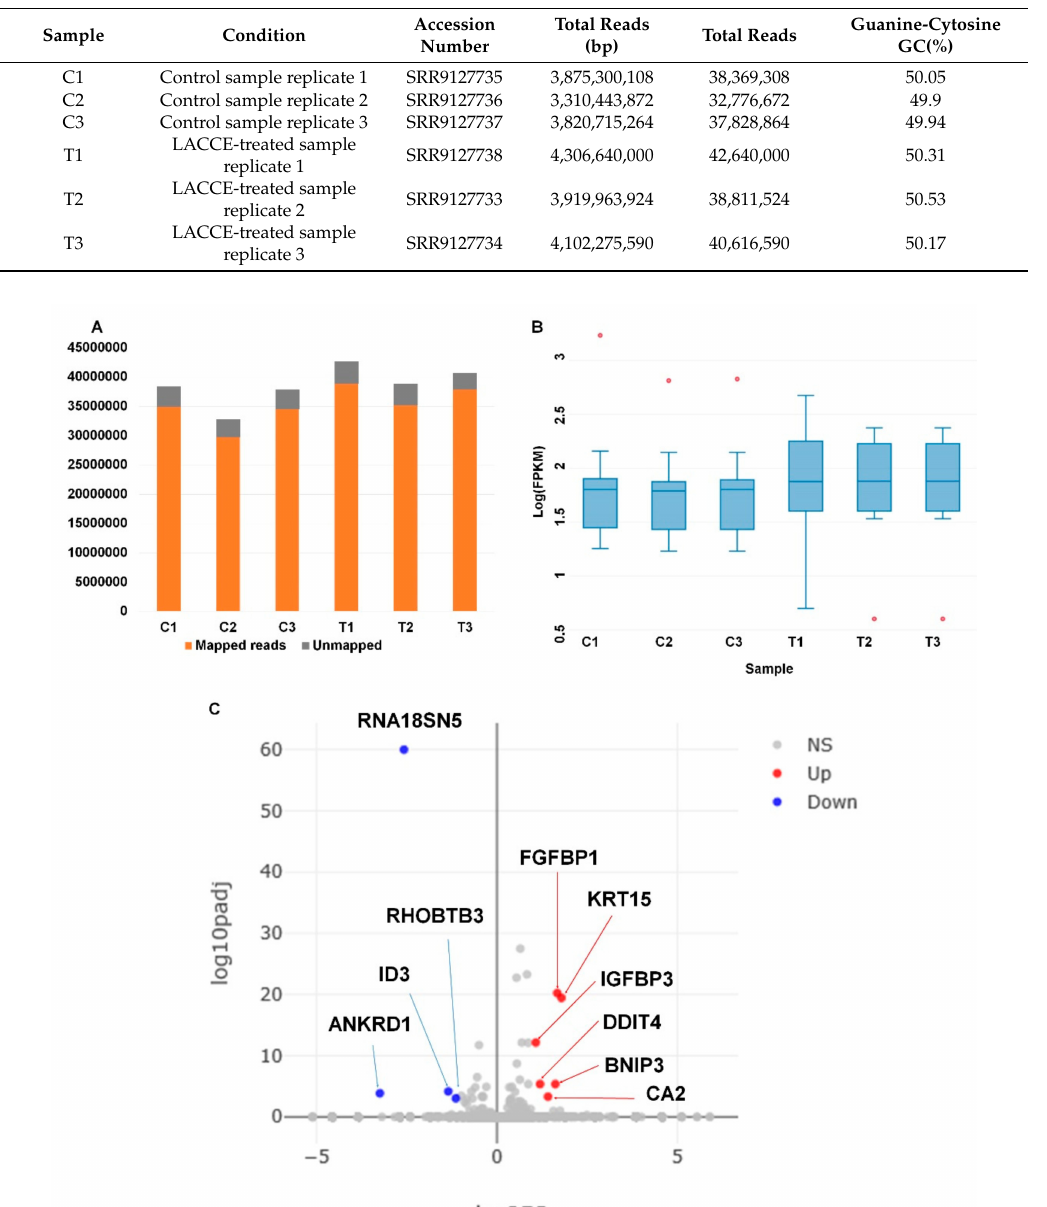
Table 5. Summary of raw sequence data and accession numbers.